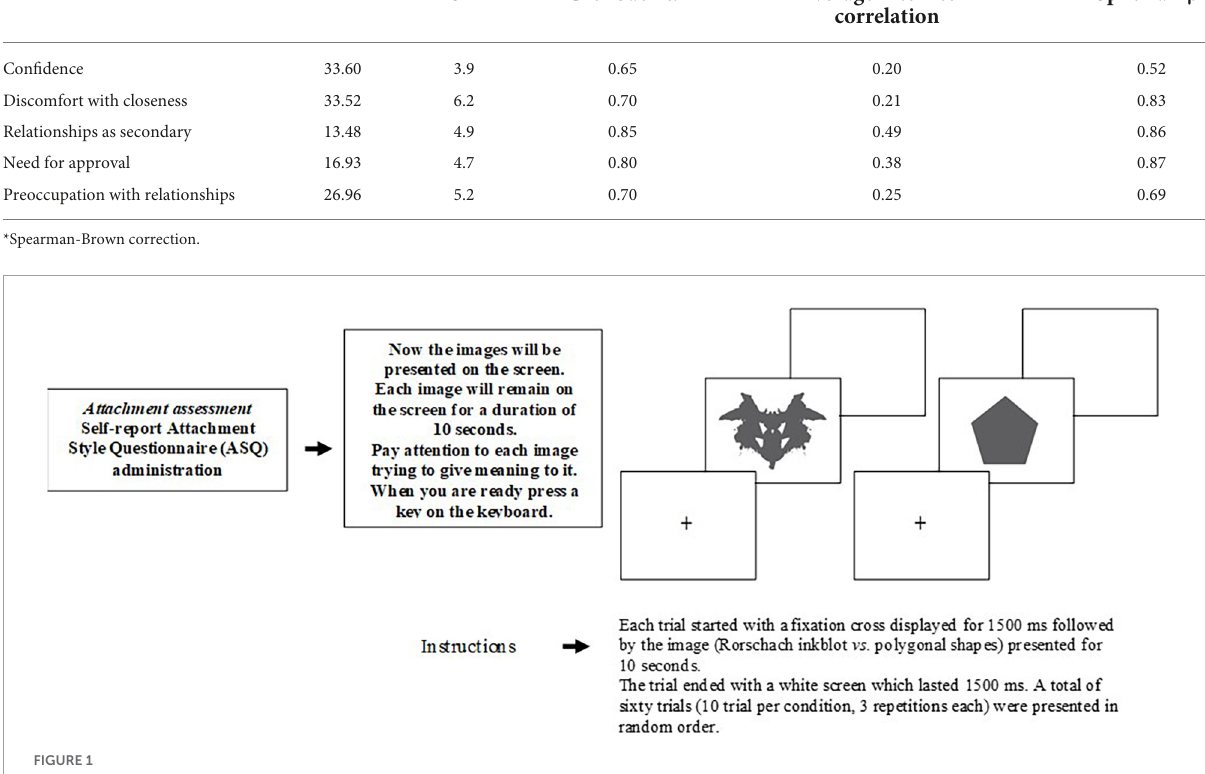
FIGURE1 The procedure of experimental visual task.